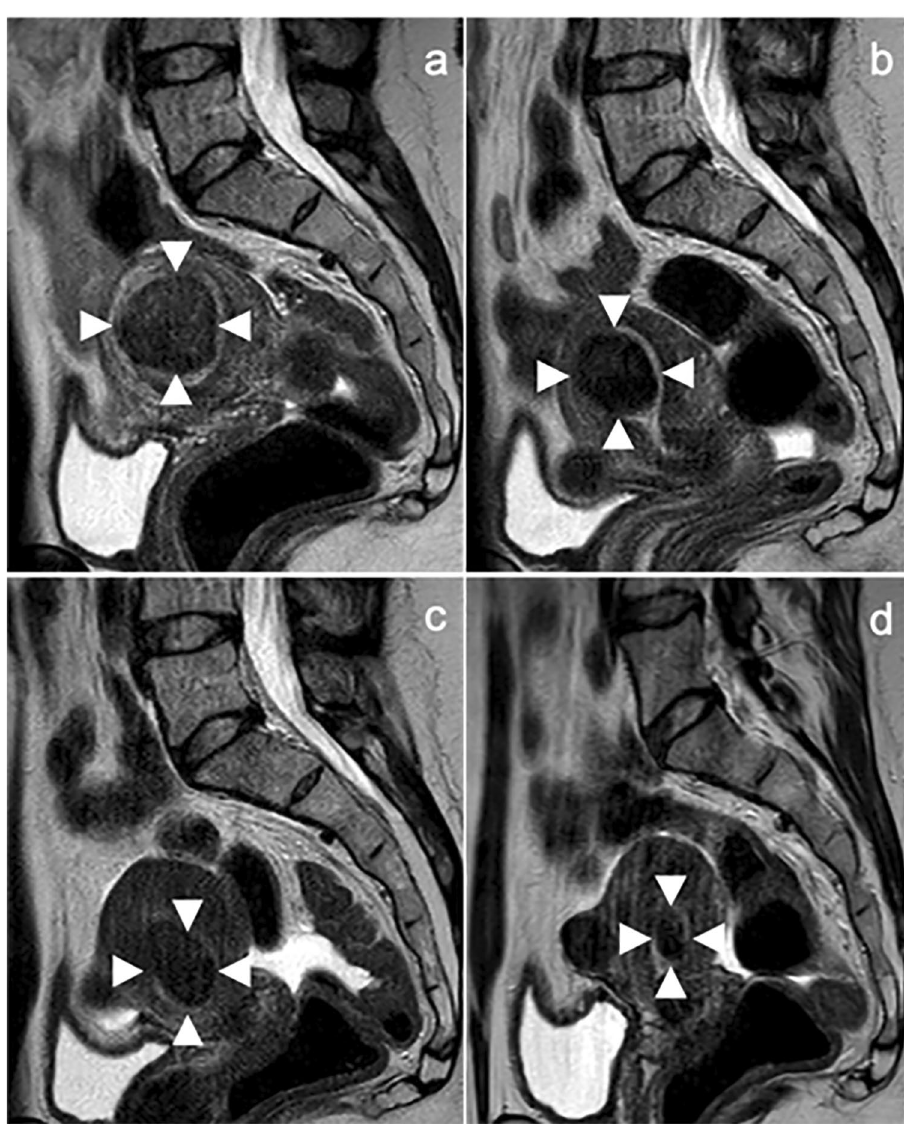
Figure 3. MRI-images (sagittal T2-weighted sequences) of a 41-yearS old premenopausal patient with multiple fibroids who presented with severe fibroid-associated symptoms (hypermenorrhea, dysmenorrhea, anaemia, pelvic pain and pressure). There was no fibroid-specific previous therapy. The largest fibroid was located in the fundus of the uterus and was the main target of ablation. In the 9-month follow-up a significant reduction of tumor volume was observed. ( a ) Large predominant target myoma in the uterine fundus before HIFU treatment. ( b ) At 3-month follow-up the volume reduction was about 53.7%. ( c ), ( d ) Fibroid volume reduction of about 87.8% after 6 months ( c ) and 92.7% after 9 months ( d )